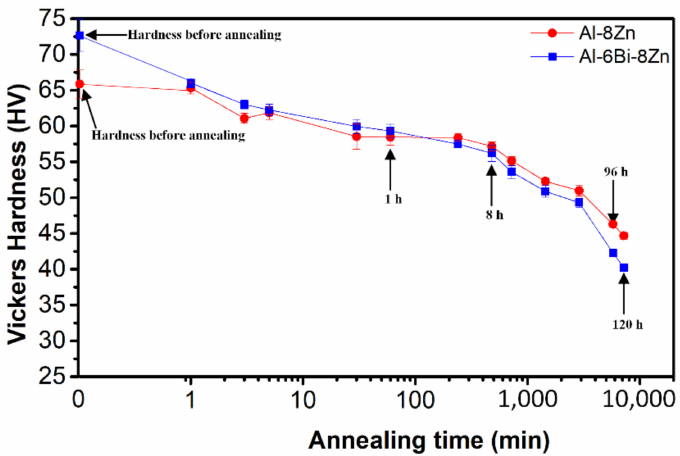
Figure 8. Evolution of Vickers hardness of the 5P Al-8Zn and Al-6Bi-8Zn alloys as a function of annealing time at 200 ◦